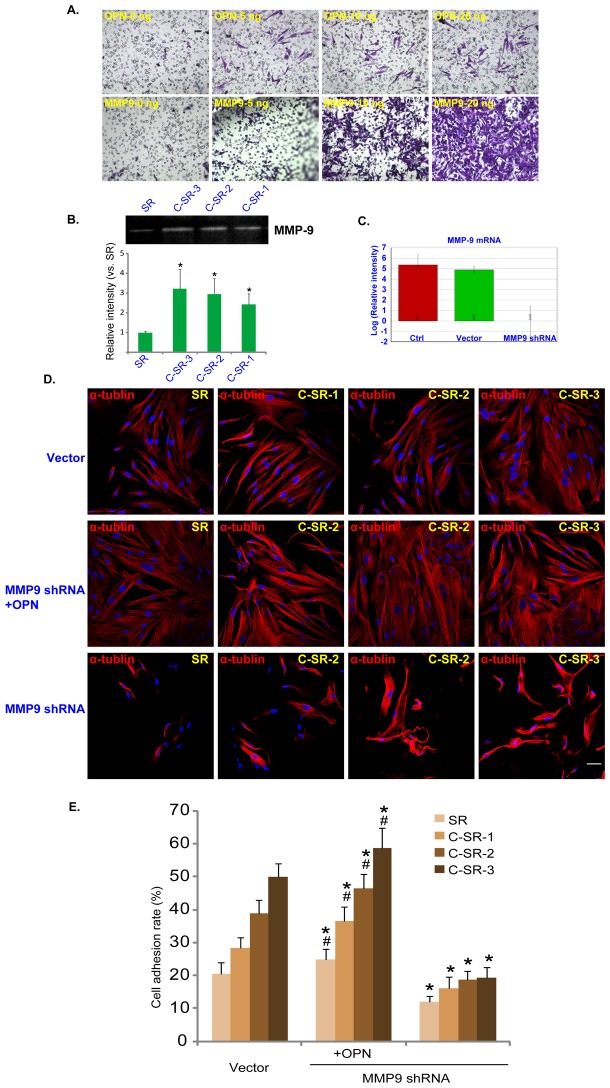
MMP-9 is important for dermal fibroblast adhesion and migration on the surface of C-SR.(A) Transwell results show that exogenously-added OPN and MMP-9 facilitated dermal fibroblasts migration (48 hours). (B) Zymography assay shows the MMPs activity of fibroblasts cultured on SR or different C-SR coated 6-well plate (48 hours). The difference was statistically significant when any C-SR was compared to SR (*p<0.05). (C) MMP-9 mRNA level in control dermal fibroblasts or in fibroblasts infected with MMP-9-shRNA or scramble-shRNA containing lentiviral particles. (D and E) Immuno-fluorescence results show that MMP-9 shRNA inhibited fibroblast adhesion and growth on the surface of C-SR and it was rescued by exogenously-added purified OPN (20 ng). *p<0.05 The difference was statistically significant when the substrate in group (MMP9 shRNA or MMP9 shRNA+OPN) was compared to the substrate in group (vector). #p<0.05 The difference was also statistically significant when the substrate in group (MMP9shRNA+OPN) was compared to the substrate in group (MMP9shRNA). These experiments were repeated three times, similar results were obtained each time. Bar = 20 µm. The cell adhesion test was performed six times, the data are expressed as mean ± SD (Fig. 5E).